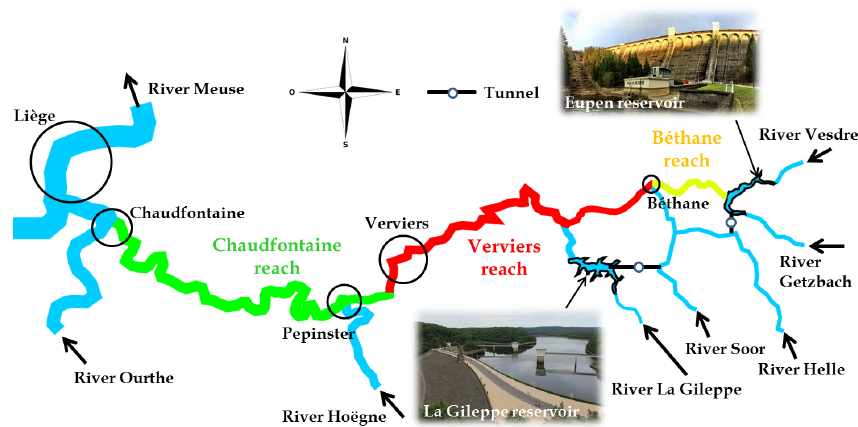
Figure 1. Vesdre valley from upstream of the Eupen reservoir to the mouth into the River Ourthe, which flows into the River